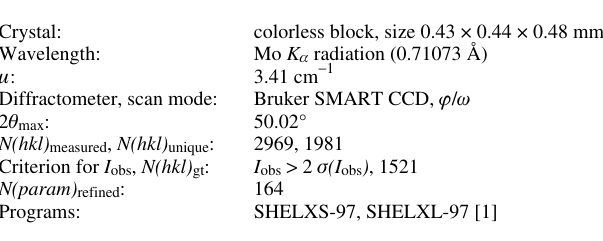
Table 1. Data collection and